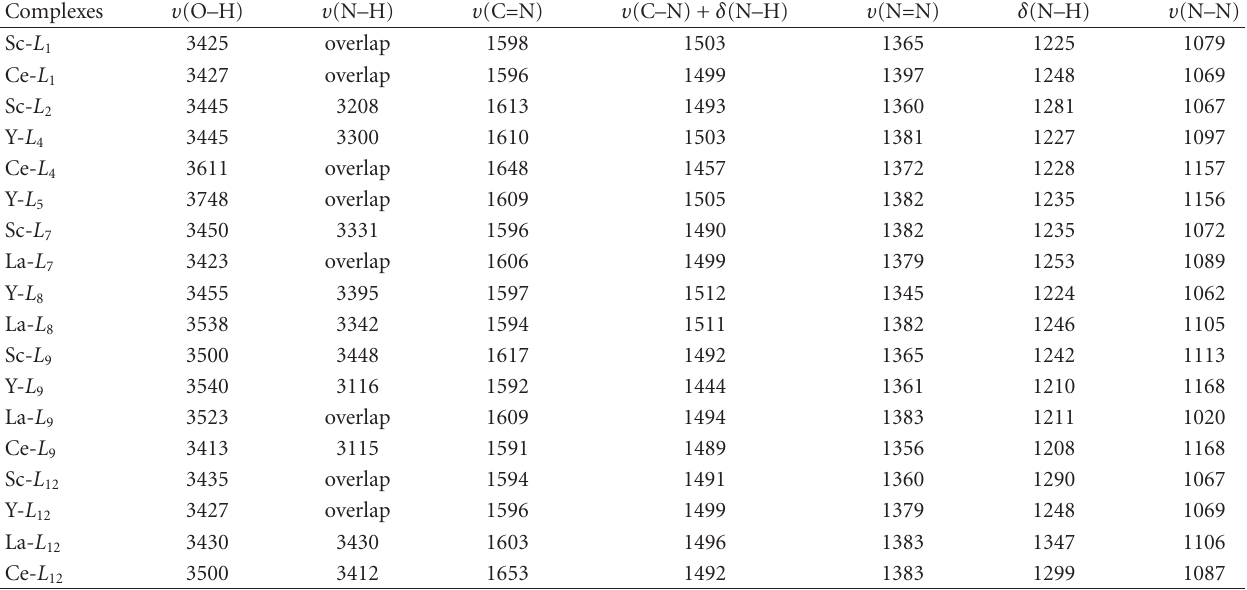
Table 6: Selected infrared data of complexes (cm − 1 ).